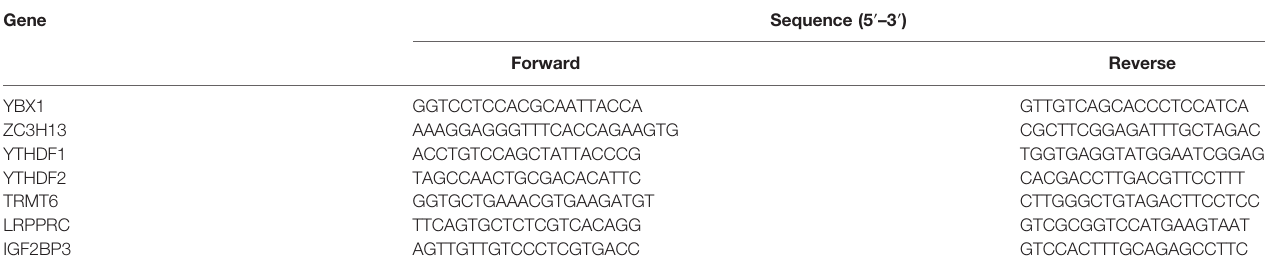
TABLE 1 | The primer sequences of m6A/m1A/m5C regulated genes. Gene Sequence (5 ′ – 3 ′ )